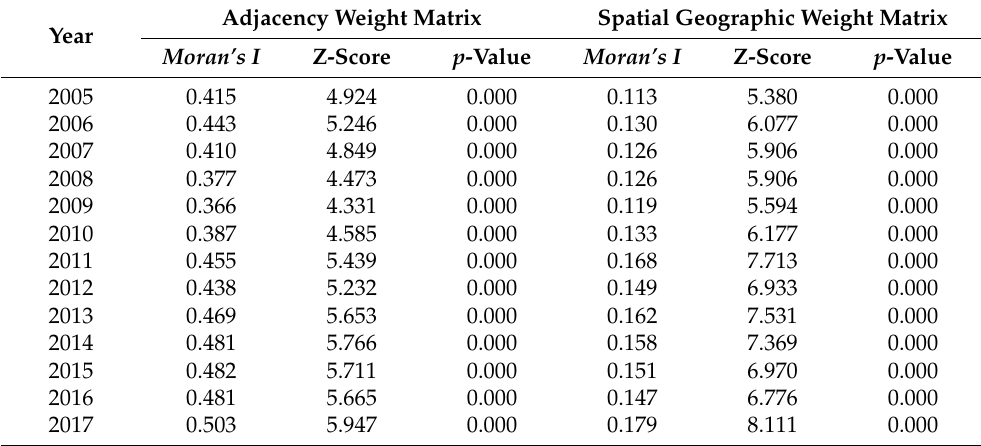
Table 2. Results of global correlation analysis.